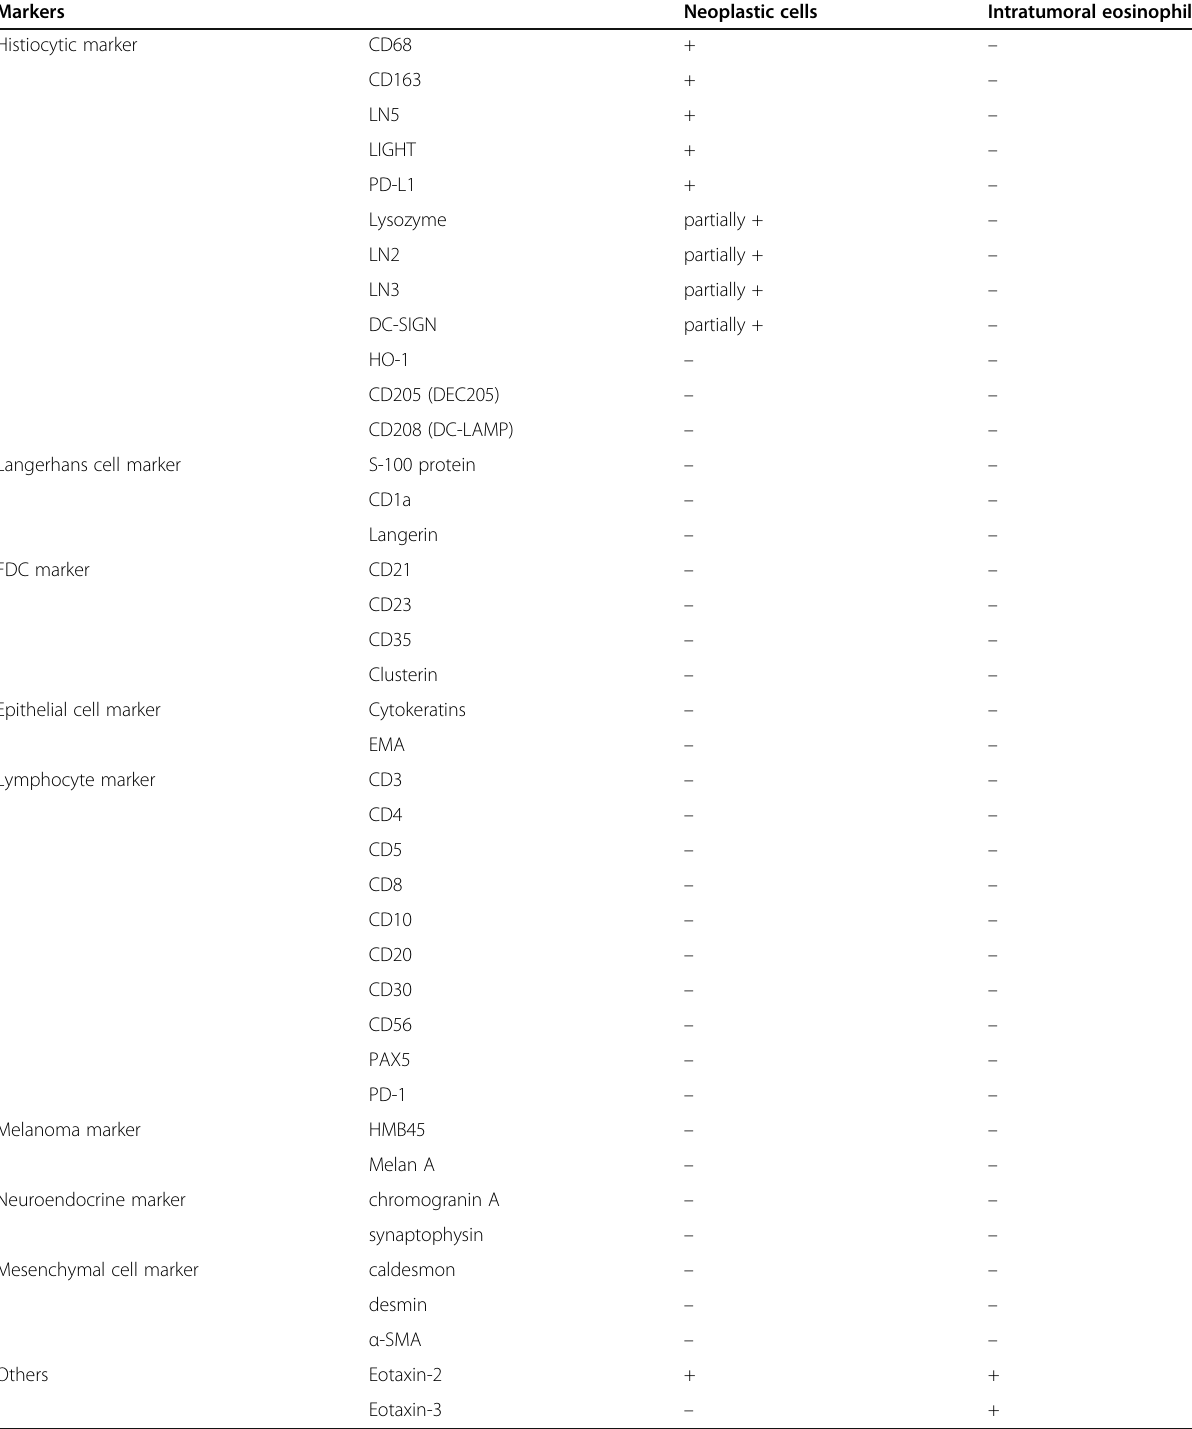
Table 1 Immunohistochemical findings of this